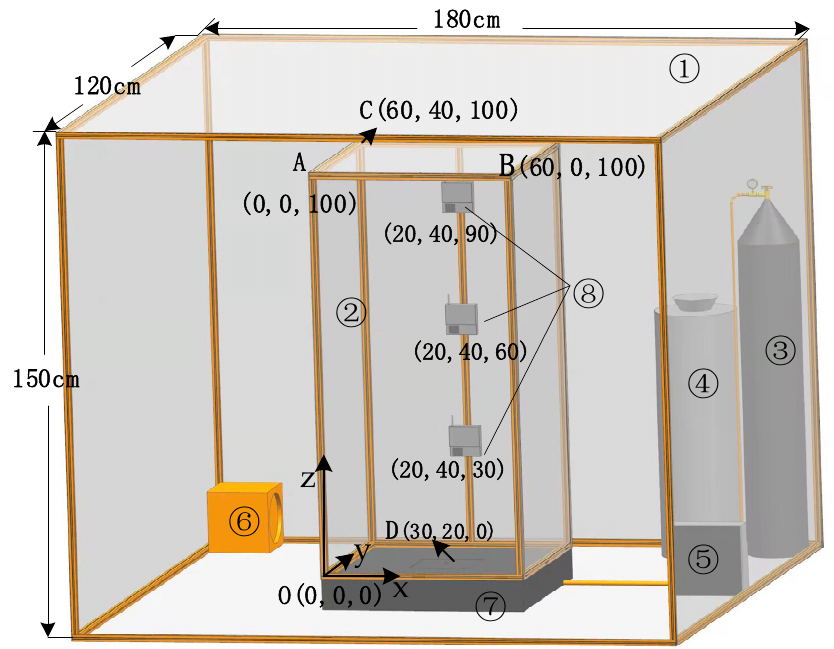
Figure 2. Schematic diagram of the experimental environment. 1 (cid:13) Temperature control box; 2 (cid:13) incu- bator; 3 (cid:13) CO 2 cylinder; 4 (cid:13) storage tank; 5 (cid:13) micro/nanobubble generator; 6 (cid:13) temperature regulating equipment; 7 (cid:13) spraying components; and 8 (cid:13) data monitoring